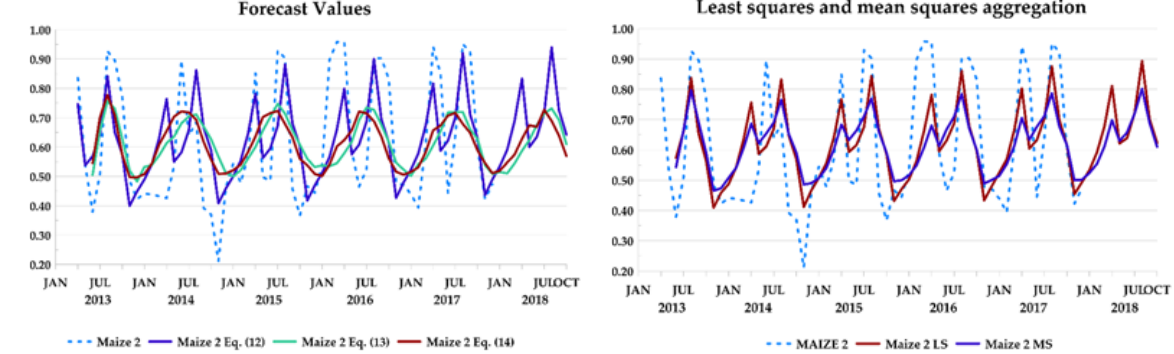
Figure 6. Forecast values for one-year time horizon given by the estimation models presented in Equations (12)–(14) and least squares and mean squares aggregation models.